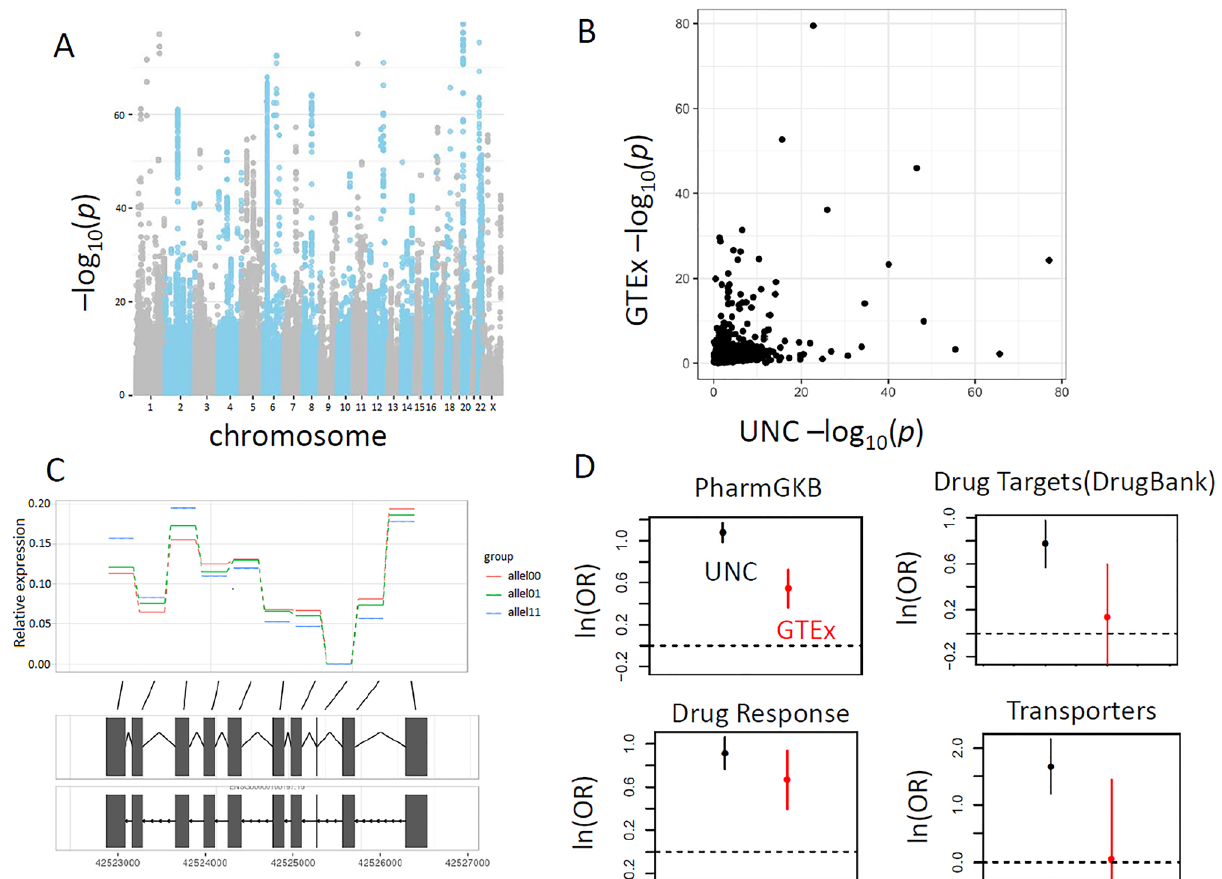
Figure 3. This study is a large compendium of liver splicing regulation information. ( A ) Splicing (exon usage) eQTLs, with minimum p value per gene shown. ( B ) Liver splicing eQTL p values (minimum per gene) shown, GTEx liver vs. UNC liver (Spearman ρ = 0.19, p < 0.0001). ( C ) Average exon-usage per genotype for rs3892097 shows the effect of the SNP on splice variation on Cyp2D6 . ( D ) Enrichment of pharmaco-gene sets for gene- level splicing eQTLs. Enrichment for the UNC liver data was significantly greater than that of GTEx liver for PharmGKB ( p < 0.001 after multiple comparison correction), while other gene categories were suggestive but not figure conceptually highlights a region containing genes with high rank for liver eQTL effects, but low rank for non-liver eQTL effects. The nature of the HT-eQTL model does not enable a fully probabilistic inference for